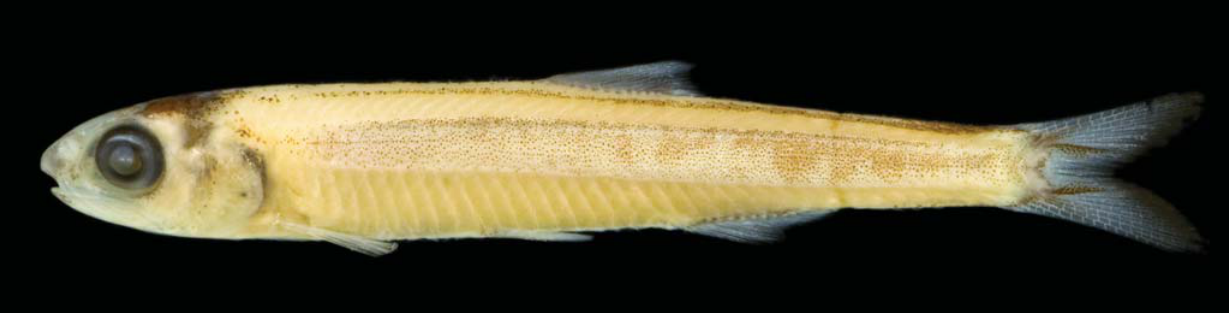
Fig. 1. Anchoviella juruasanga , holotype, MZUSP 15831, 42.4 mm SL, rio Trombetas, Trombetas, Pará State.